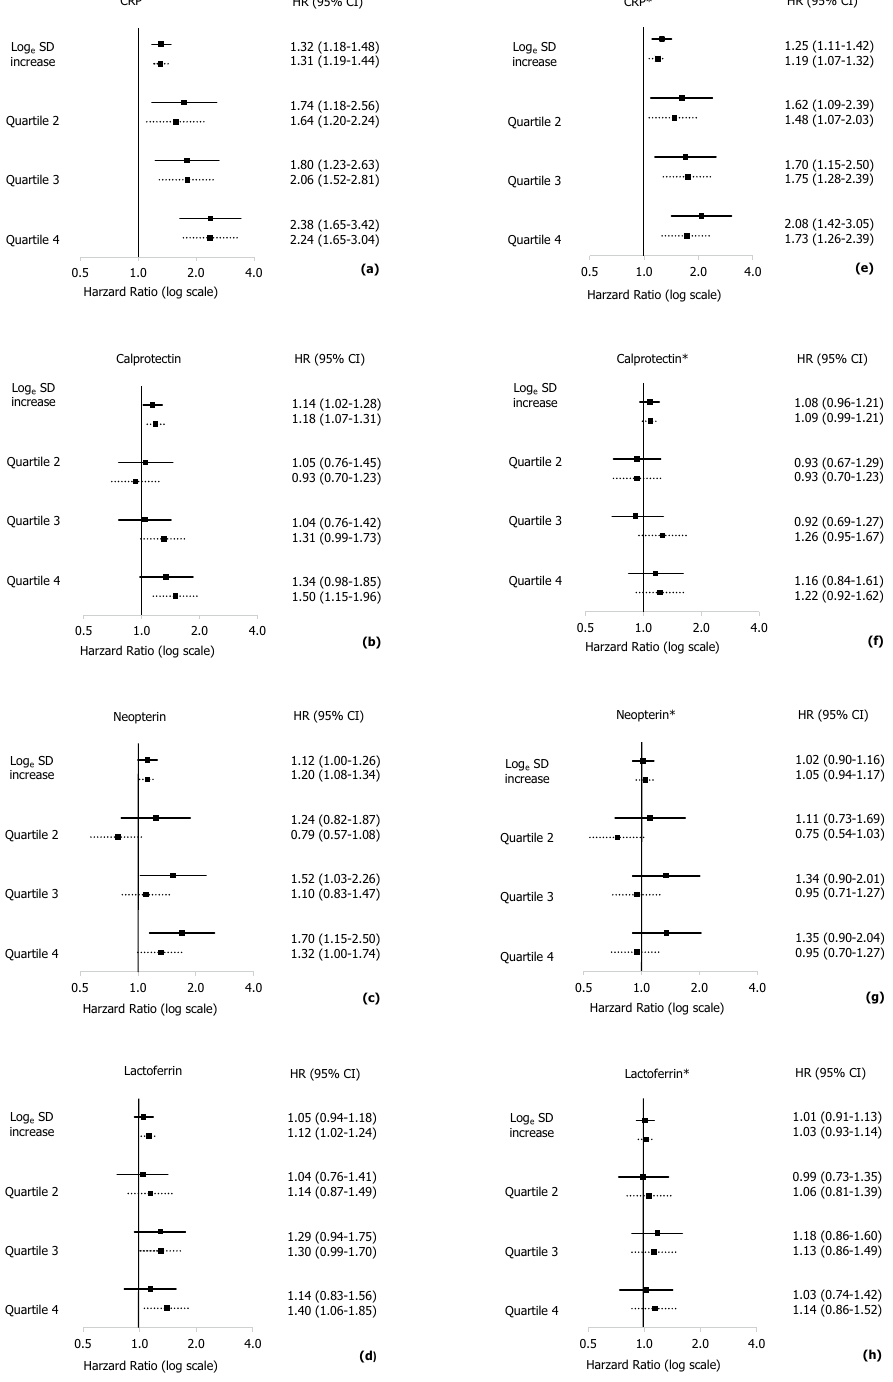
Figure 2. Inflammatory markers and risk of cardiovascular mortality according to diabetes status. CI Confidence interval, HR Hazard Ratio, CVD cardiovascular disease. HR and 95% CI computed per standard deviation (SD) log e concentration of inflammatory markers and within quartiles of distributions (non- transformed values) separately for individuals without diabetes (solid lines) and with diabetes (dotted lines). Panel ( a – d ) Adjusted for age (time-axis) and sex. Panel ( e – h )*: Additionally adjusted for prevalent CVD (self-reported history of myocardial infarction, angina pectoris or stroke), hypertension, smoking status, total cholesterol, HDL cholesterol, triglycerides, creatinine and body mass index